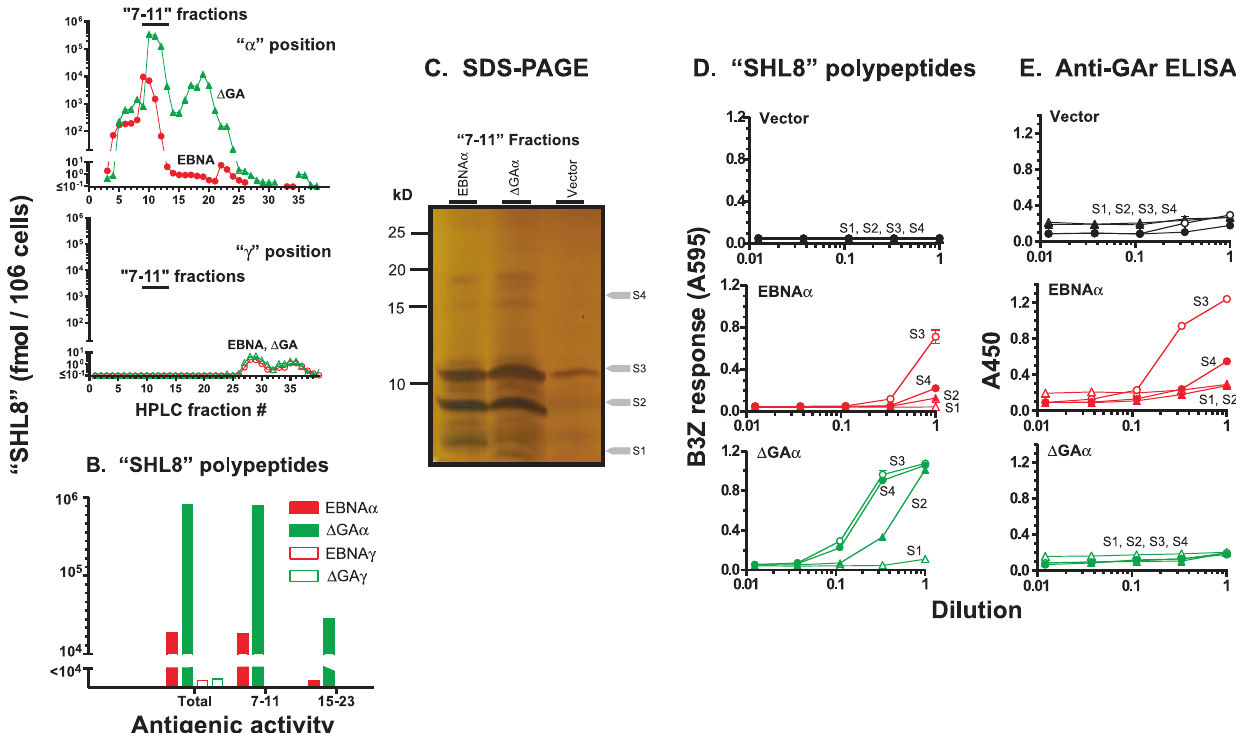
Figure 5. Generation of DRiPs in living cells. ( A ) HEK293 cells were induced to express EBNA or D GA with SHL8 in position ‘‘ a ’’ (upper panel) or ‘‘ c ’’ (lower panel) with doxycycline for 24 h. The cell extracts were passed through 30kD molecular weight filters and the , 30kD filtrates were fractionated by HPLC. Each HPLC fraction was treated with trypsin and CPB and the amount peptides containing ‘‘SHL8’’ was determined. ( B ) The total amount of ‘‘SHL8’’ activity recovered in the polypeptides eluting in all HPLC fractions versus fractions ‘‘7–11’’ and ‘‘15–23’’. Data represent 3 different experiments. ( C ) HEK293cells expressing vector alone, EBNA a or D GA a were cultured for 24h with doxycycline. Thecell extracts were passed through 30 kD molecular weight filters and fractionated by HPLC. The polypeptides in fractions ‘‘7–11’’ were pooled and separated on tricine 16.5% SDS-PAGE. The silver-stained gels shown is representative of three different experiments. ( D ) The indicated slices (S1–S4) were cut from the gel and digested for 8 h by trypsin. Each digested slicewassplitinto twoaliquots.Aliquots from theindicated vector, EBNA a or D GA a samples werefurtherdigested with CPBfor4 h.The‘‘SHL8’’ activity was measured in the indicated dilutions using B3Z T cells and K b -L cells as APC. The B3Z response is shown as products of the lacZ substrate CPRG as in Fig. 4. ( E ) The presence of the GAr motif was detected by an ELISA assay using a mouse anti-GAr antibody and anti-mouse conjugated to horse-radish peroxidase. Data shows the absorbance (A450) of the peroxidase substrate converted in 30 min.